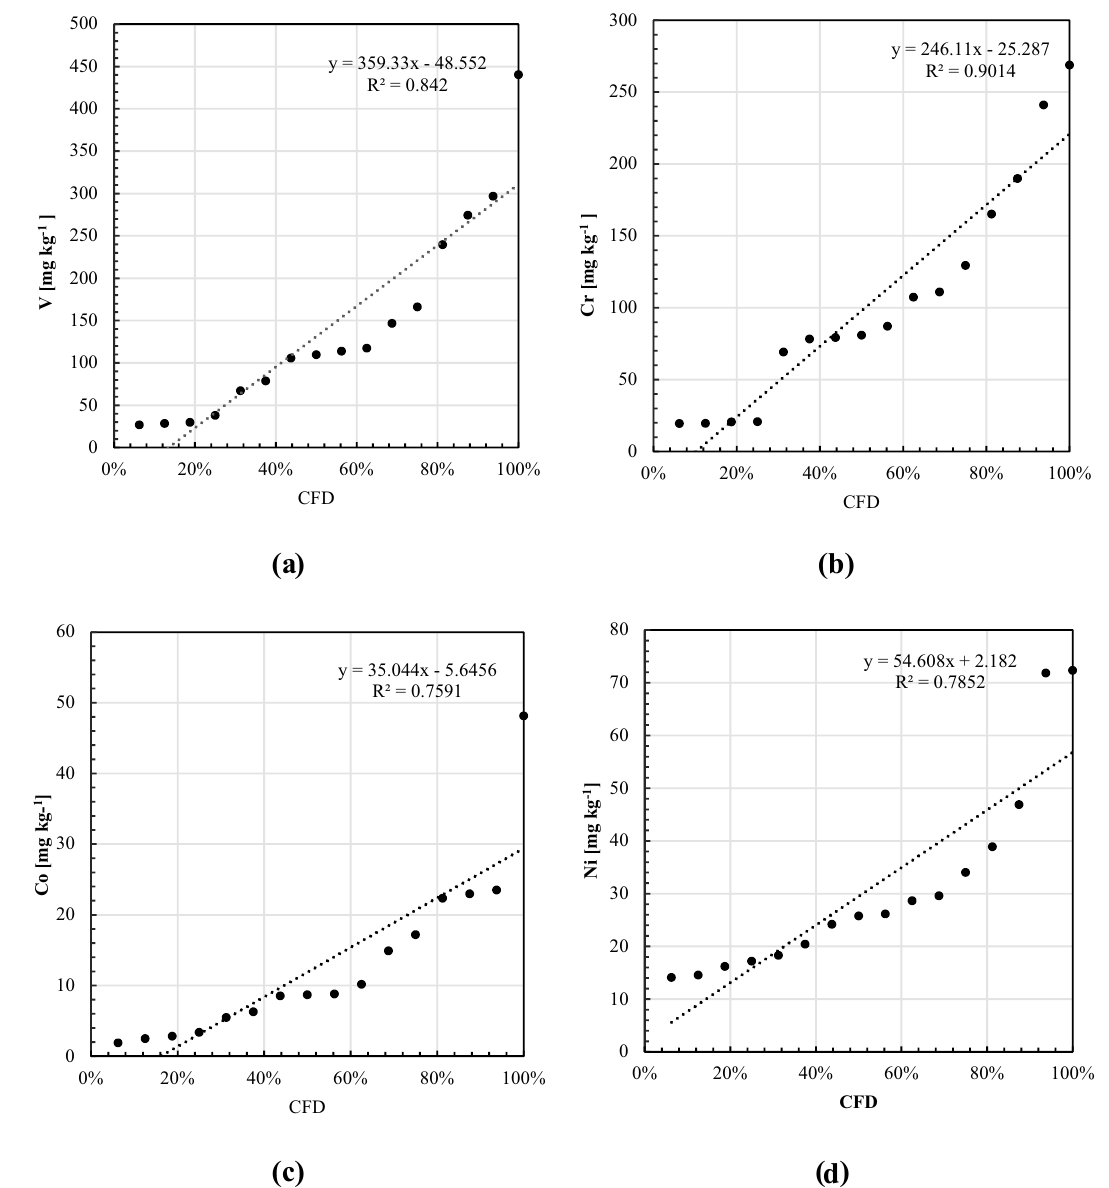
Fig. 14 Cumulative frequency curve method for vanadium ( a ), chromium ( b ), cobalt ( c ) and nickel ( d ) in Borgo